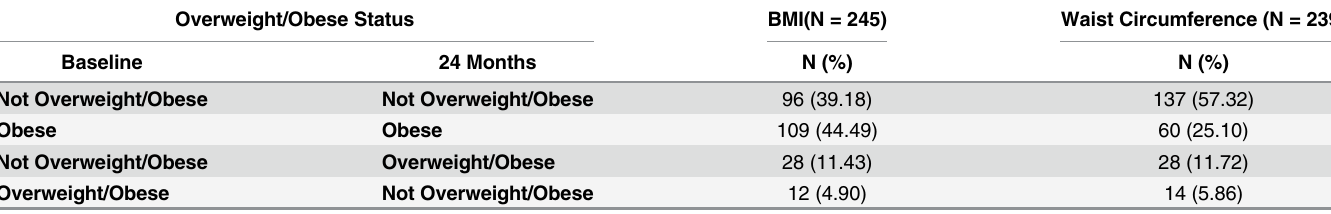
Table 2. Changes in Overweight/Obesity status from Baseline to 24